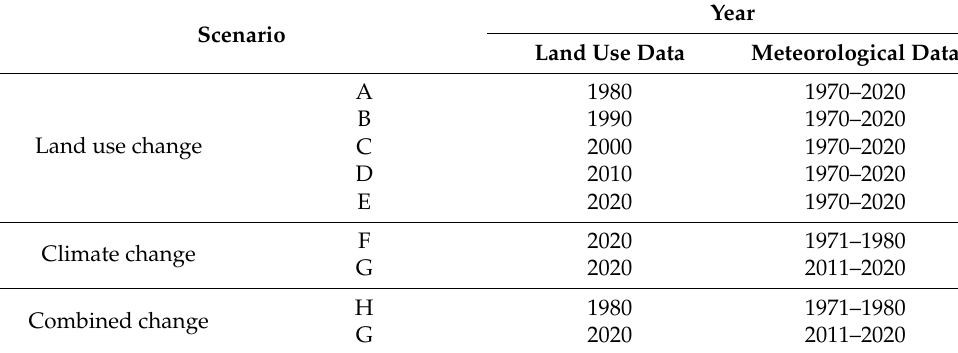
Table 1. An analysis of the scenarios set up in this study and the analysis ideas. Scenario